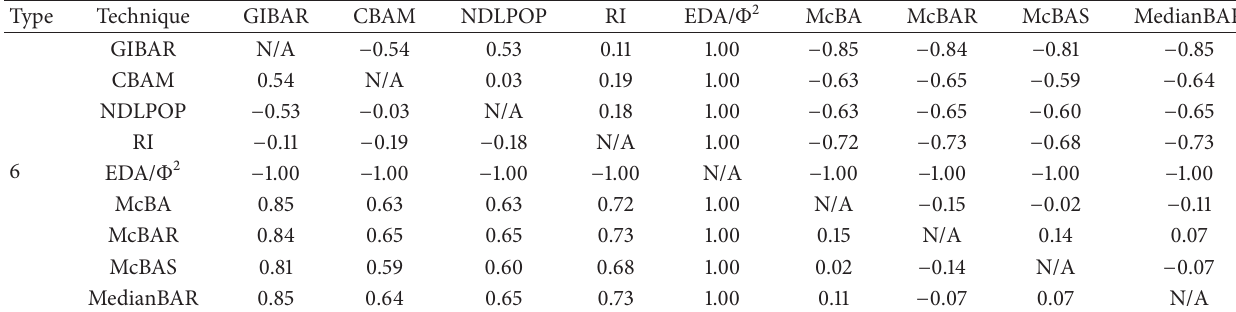
Table 11: Average E 𝜏 𝑡 [⋅] performance under change type